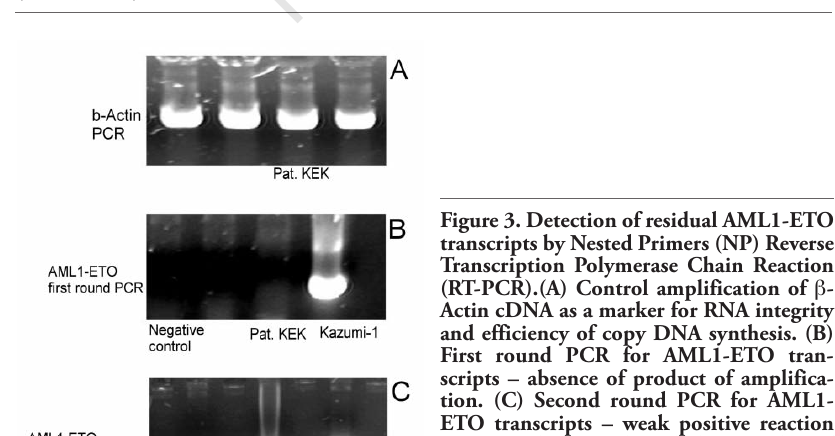
Figure 2. The karyotype corresponds to Klinefelter`s syndrome. No structural chromo- somes were detected: complete cytogenetic response regarding t(8;21)(q22;q22). Routine cytogenetic analysis was performed on metaphase chromosomes from bone marrow sam- ples using a direct method and after short-term 24 hours or 48 hours culturing. Metaphases were analyzed using GTG differentially stained chromosomes at a discrimina- tory level of 300-400 bands per haploid count. Karyotypic findings were interpreted and described according to the International System for Human Cytogenetic Nomenclature (ISCN, 2009). 8